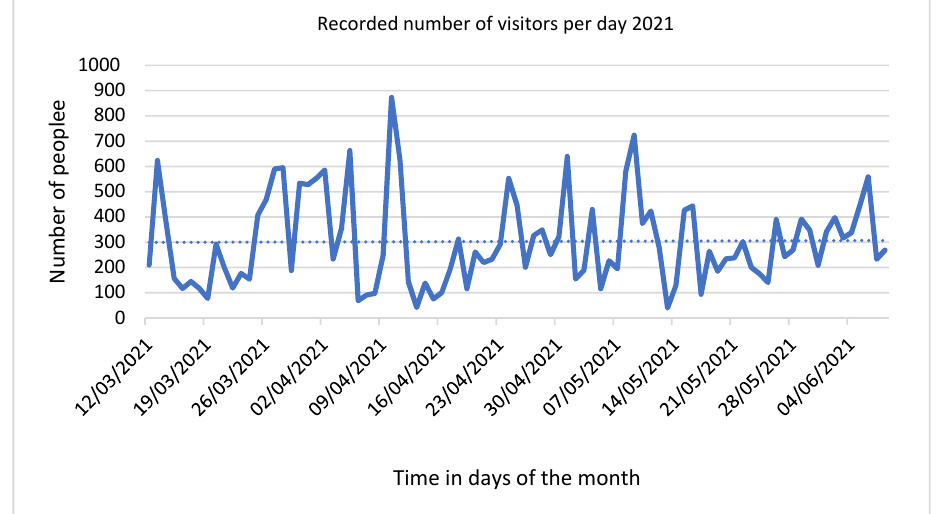
Figure A4. Recorded number of visitors per day in three months in 2018.